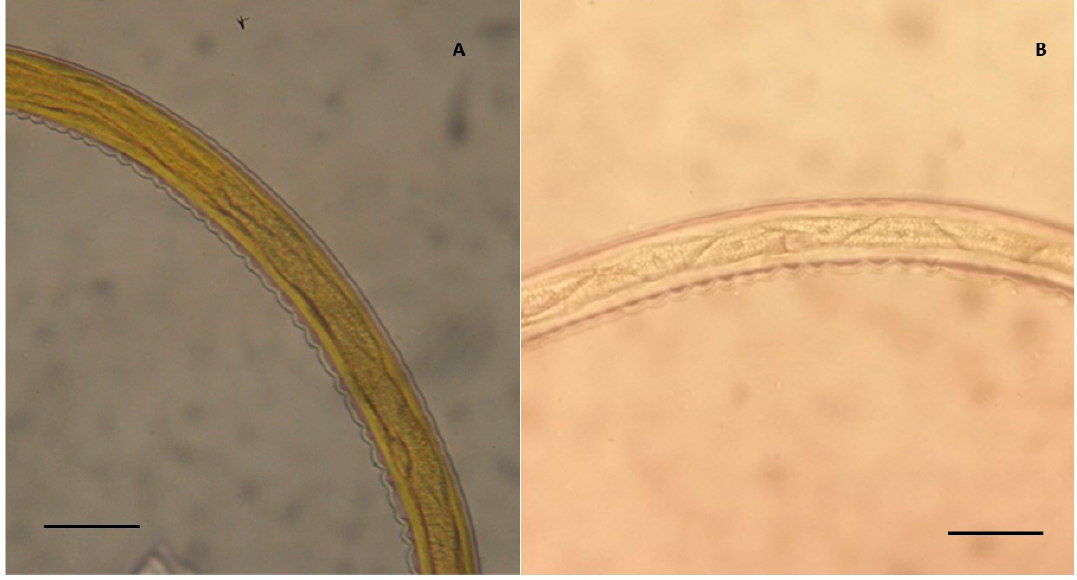
Figure 2. Detail of the body of two cyathostomin third stage larvae (L3). ( A ) L3 showing eight triangular intestinal cells, where the first two are arranged in a double row and the remaining six cells in a single row (magnification 400 × ), identified as a group 2 L3 ( Cylicocyclus nassatus , C. radiatus , C. insigne , Cylicostephanus minutus, and Cyl. poculatus ) according to Bevilaqua et al. [19], and as a type A L3 ( C. nassatus , C. insigne , C. radiatus , Cyl. minutus , Cya. catinatum , Cya. pateratum , Petrovinema poculatum ) according to Santos et al. [21]. ( B ) Type G L3 according to Santos et al. [21], showing eight trapezoidal intestinal cells with an uncharacterised arrangement. Scale bars: 50 µm.